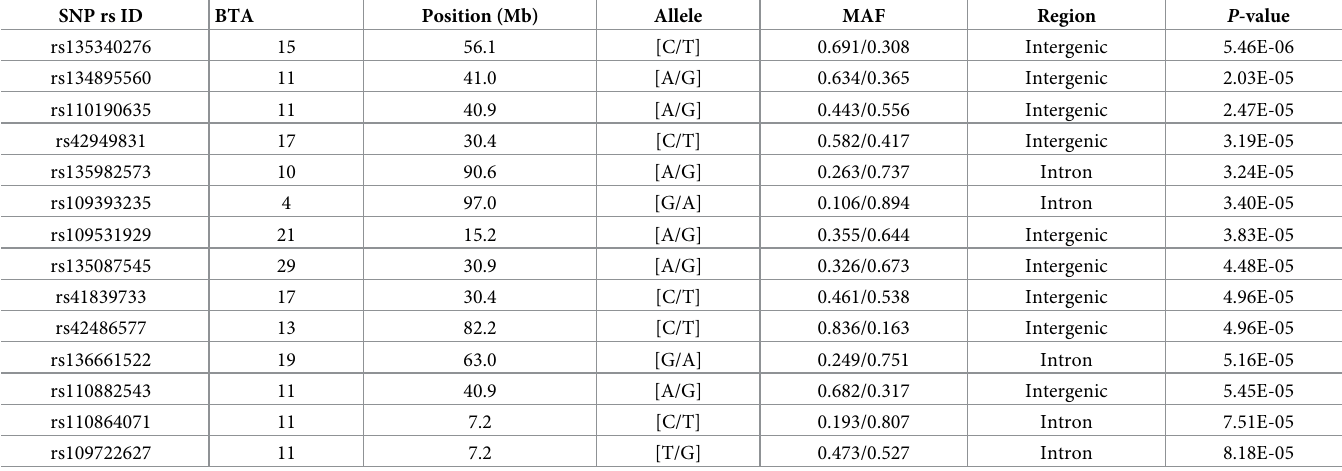
Table 1. SNPs associated with temperament evaluated as EV in Brahman